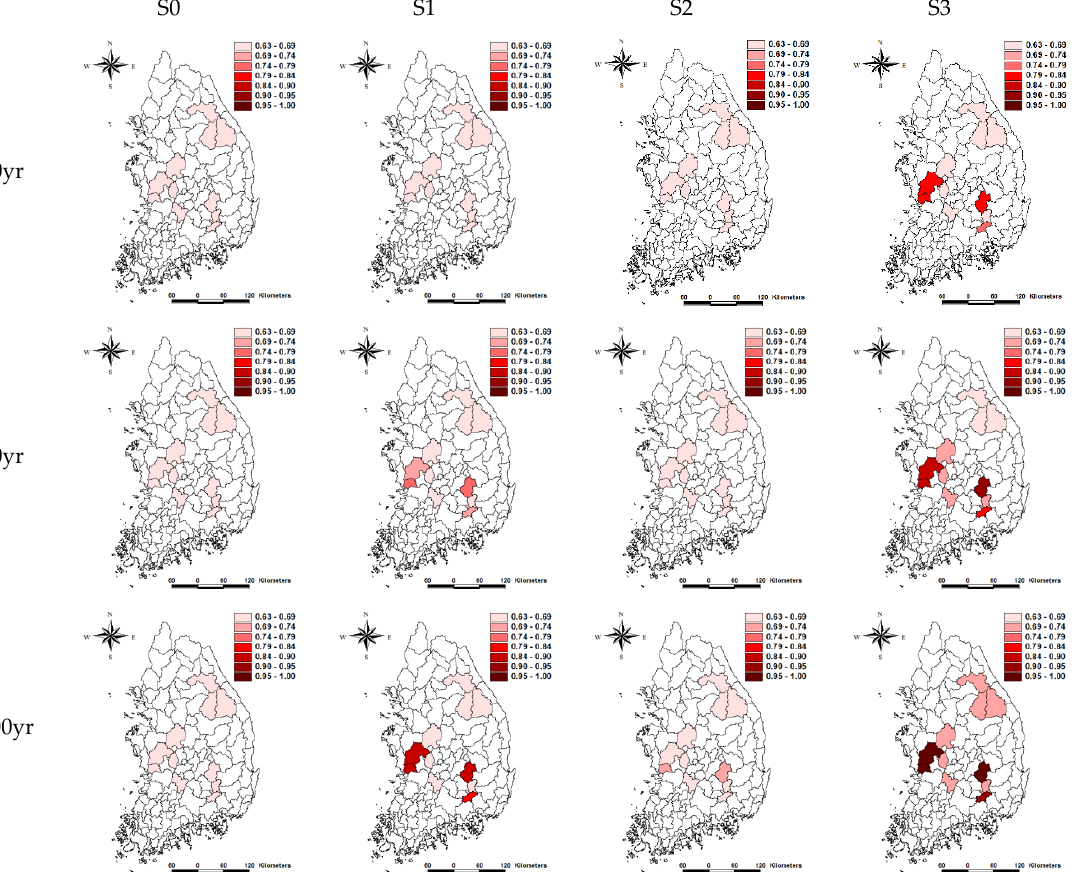
Figure 5. Flood risk map according to representative concentration pathway (RCP) 4.5 scenario.